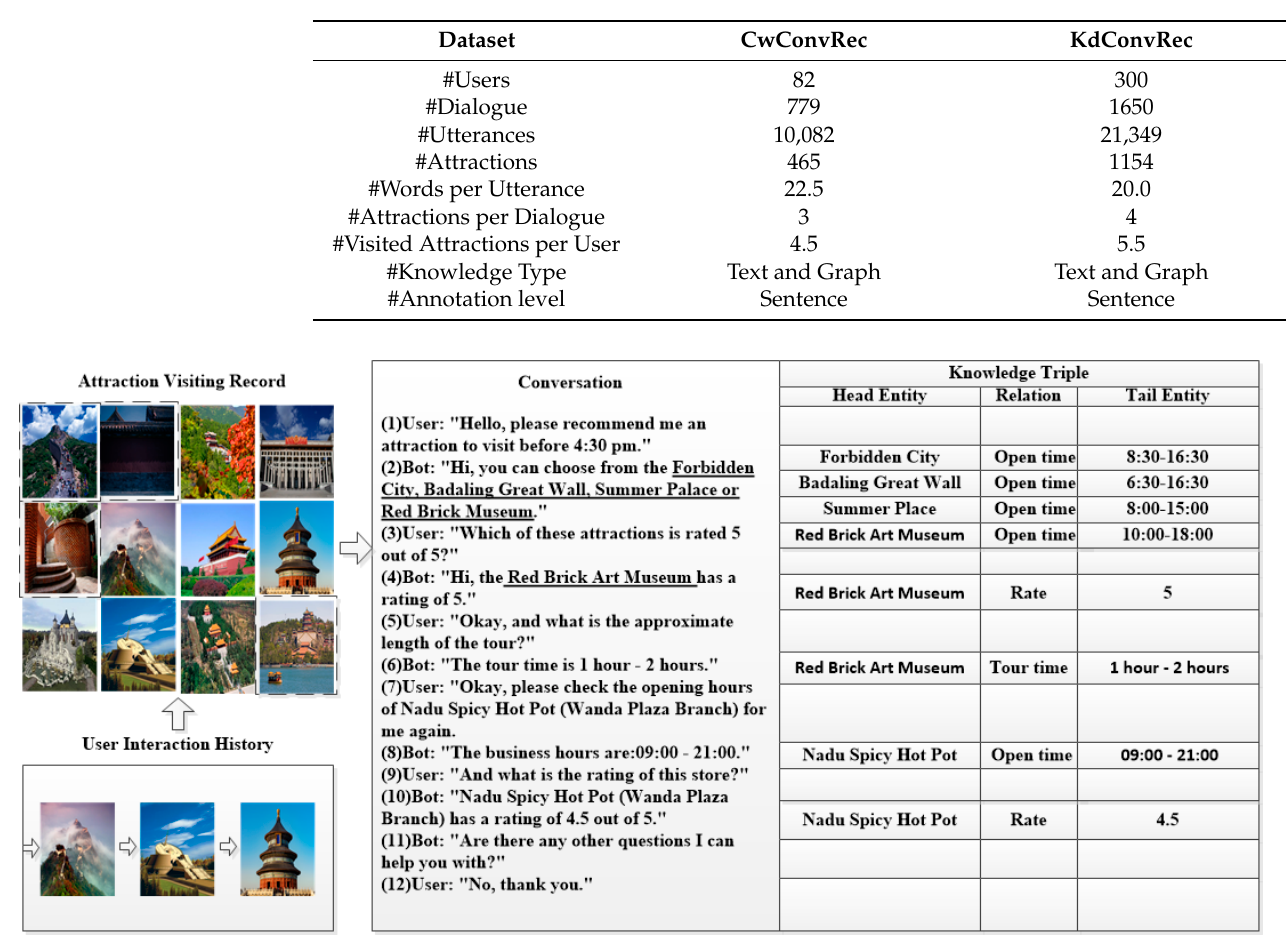
Table 1. Data statistics of our CwConvRec dataset and KdConvRec dataset.